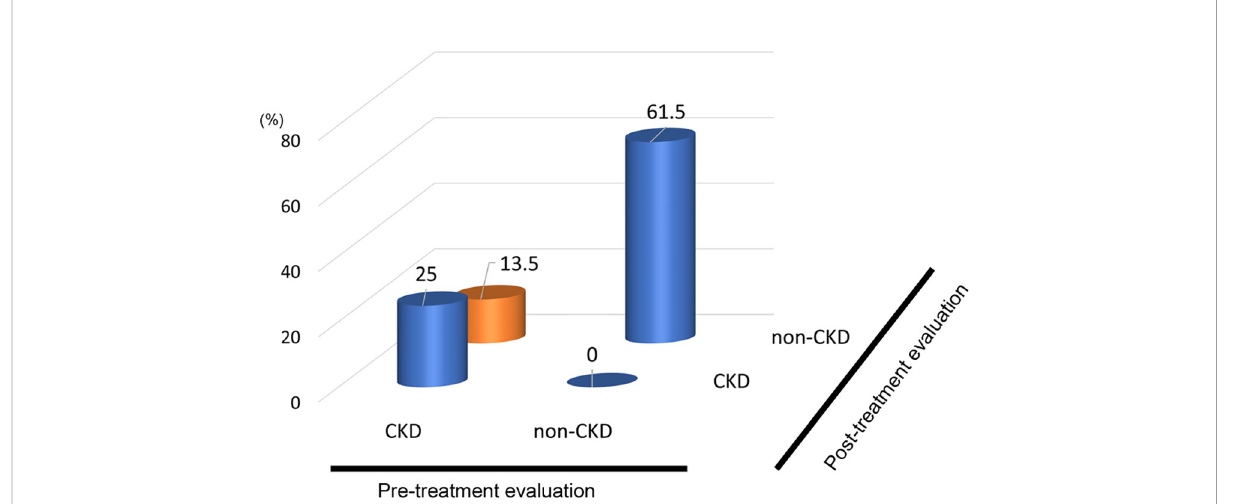
FIGURE 6 Population of “ Reversible ” CKD patients in hypothyroidism. Hypothyroidism: 13.5% pseudo-CKD in a total of 38.5% of pre-CKD cases, indicating 35% CKD were reversible.